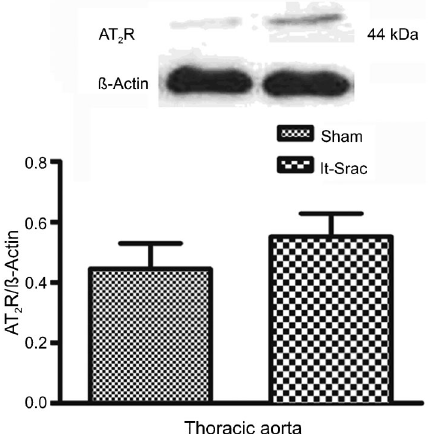
Figure 7. Western blot analyses for AT 2 R protein in long-term pressure-overloaded rat aortas. Thoracic aortas were obtained from rats 8 weeks after suprarenal abdominal aortic coarctation (lt-Srac) and sham surgery (Sham). Upper , A representative Western blot is depicted. Lower , The intensity of the bands was quantified using densitometric analysis and normalized with the corresponding b -actin. Data are reported as means±SE of 12 rats by group. Data were not significantly different (unpaired Student t -test).